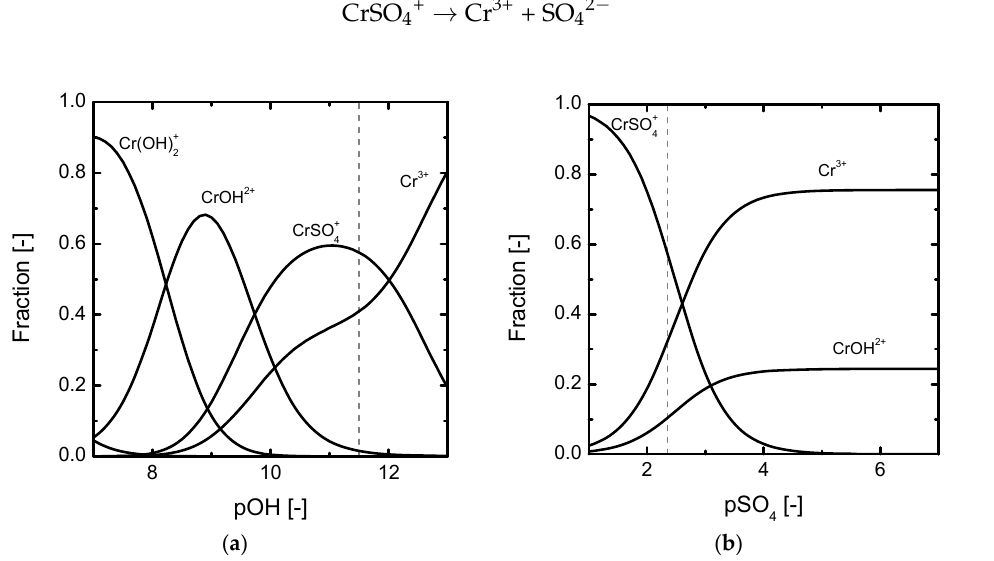
Figure 3. Equilibrium diagrams for 2.5 × 10 − 3 M Cr 2 (SO 4 ) 3 solutions: ( a ) Speciation diagram as a function of pOH, ( b ) speciation diagram as a function of pSO 4 .